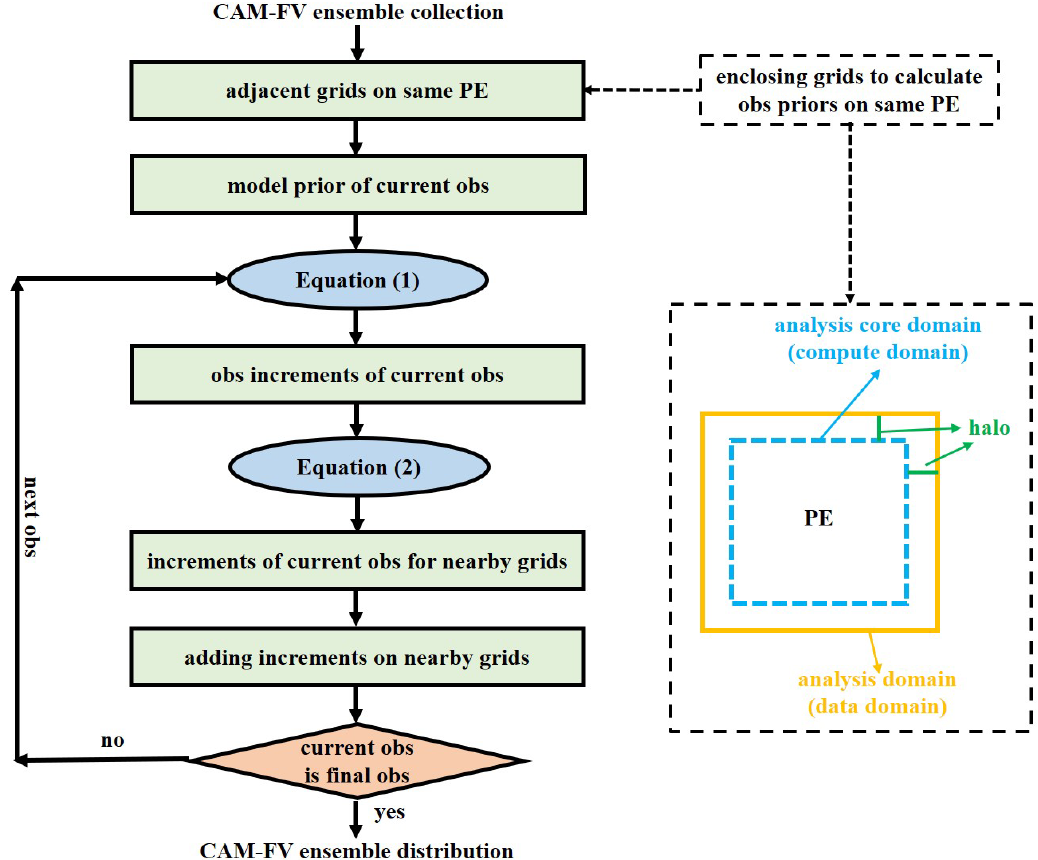
Figure 2. Schematic of the implementation of the sequential EAKF algorithm with CAM-FV. The implementation is based on the two-step method of EAKF. The decomposition strategy allows adjacent grids to be divided into the same analysis domain (i.e., onto the same analysis PE). One analysis core domain (compute domain) and its halo constitute one analysis domain (data domain). When the observations at a given time are available, only the prior ensemble of a single observation is first computed. Then each observation is assimilated sequentially according to the two-step EAKF algorithm. The observational increments of an observation only regress on the nearby model